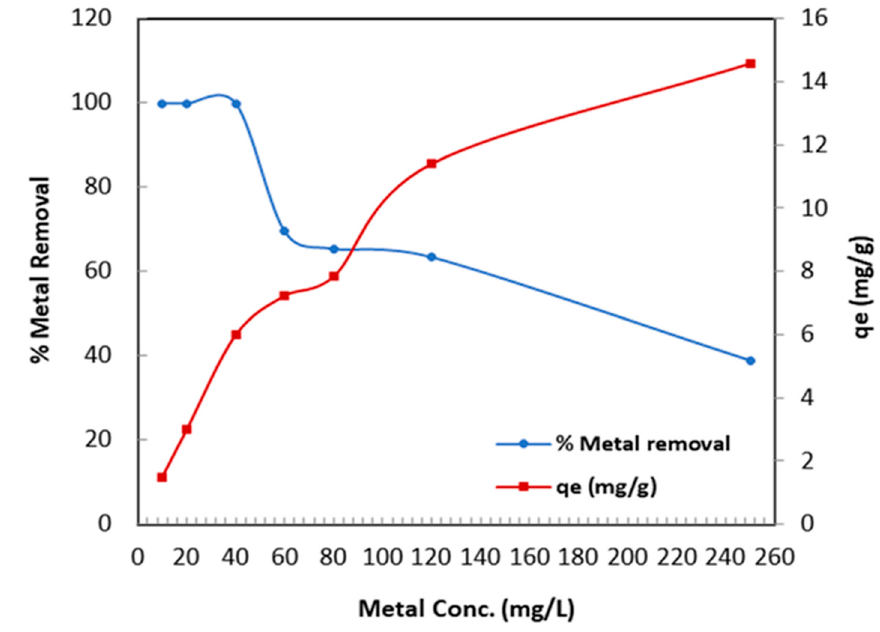
Figure 8. In fl uence of Cr (VI) metal ion concentration on metal removal and adsorption capacity. Figure 8. Influence of Cr (VI) metal ion concentration on metal removal and adsorption